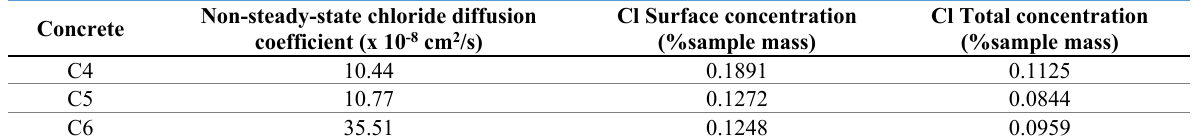
Table 11. Concrete transport parameters